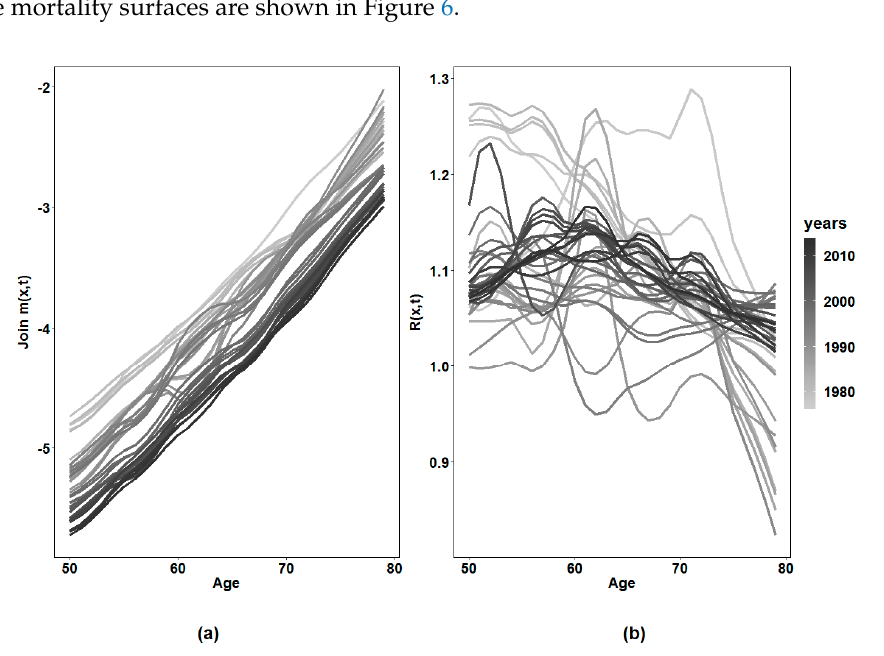
Figure 6. ln( m B ) and R x , t observed during 1977–2014: ( a ) the annual mortality curves in log scale; and x , t Figure 6 . ln( 𝑚 (cid:3051), (cid:3047)(cid:3003) ) and 𝑅 (cid:3051),(cid:3047) observed during 1977–2014: ( a ) the annual mortality curves in log scale; ( b ) the age pattern of the male–female mortality ratio for the di ff erent years. Even if some di ff erences and ( b ) the age pattern of the male–female mortality ratio for the different years. Even if some can be easily identified when comparing R x , t in di ff erent years, relative stability is observed for recent differences can be easily identified when comparing 𝑅 (cid:3051),(cid:3047) in different years, relative stability is years (1998–2014) and an overall decrease can be observed regularly at all observed for recent years (1998–2014) and an overall decrease can be observed regularly at all ages.